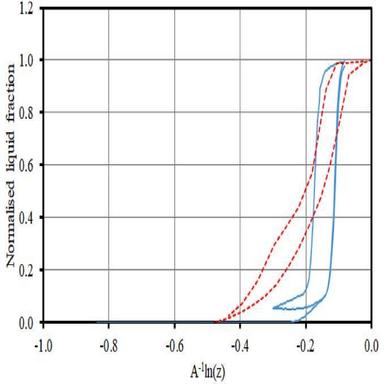
A comparison of the gas sorption data for whole pellet sample of E2 with the NMR cryoporometry data for slice number 6 (from) using the unified co-ordinate system described in the Theory section. The adsorbate property factor was 0.953 nm, while the Gibbs Thomson parameter used was 52 K nm, working in pore diameter.